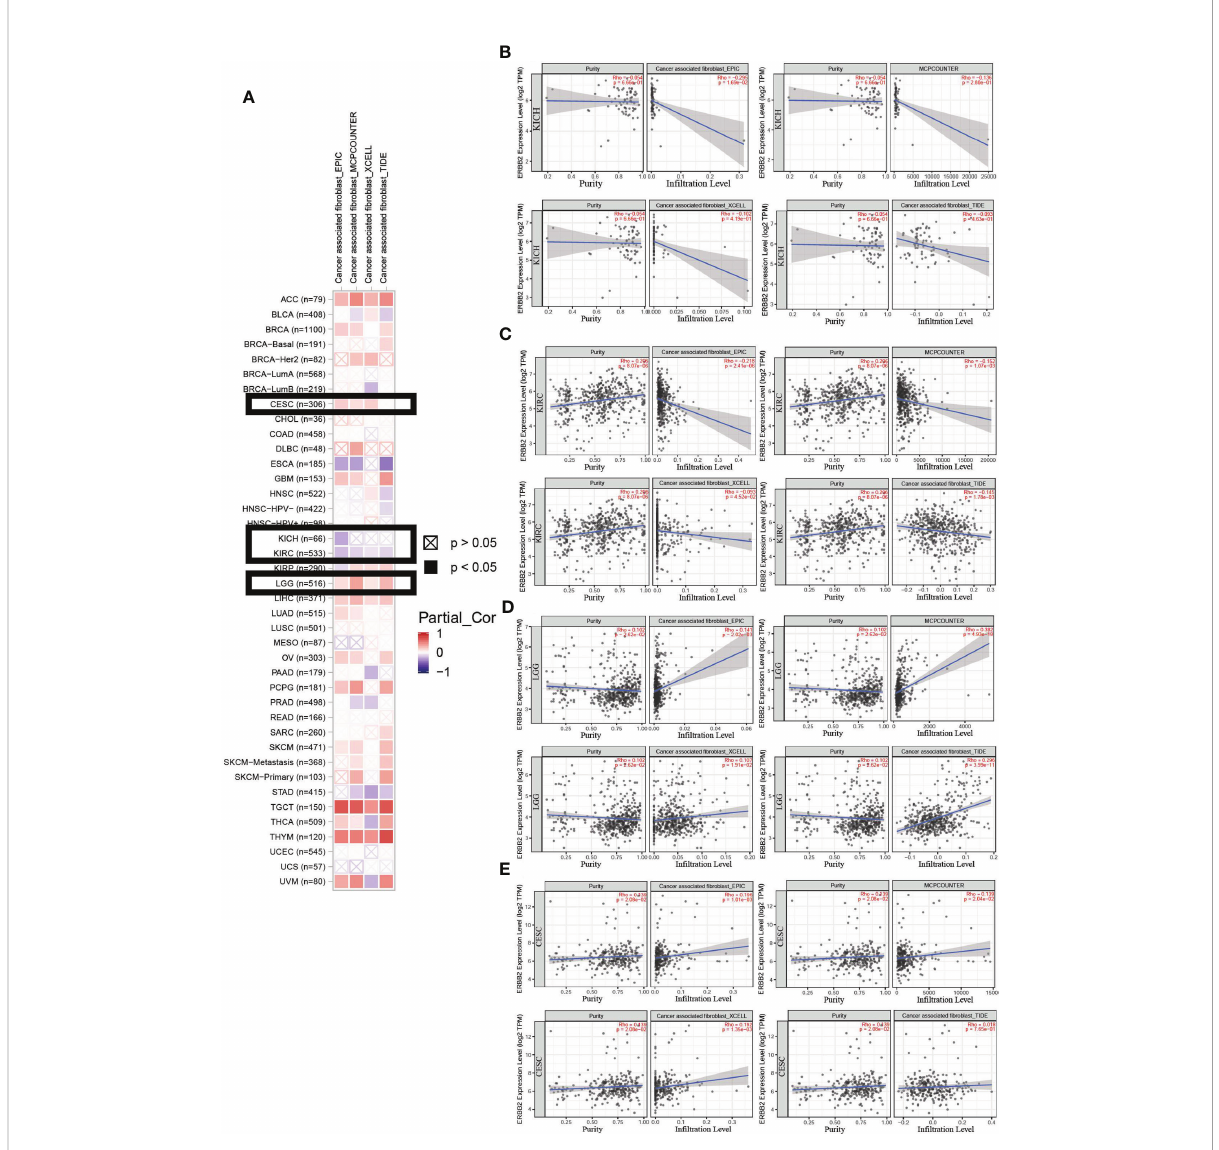
FIGURE 4 An analysis of the cancer-associated fi broblast in fi ltration using the four estimation algorithms. (A) An example of the scatter plot from the ‘ Mutation Module ’ displays the difference in TIMER-estimated cancer-associated fi broblast in fi ltration of KICH, KIRC, LGG, and CESC using the four estimation algorithms, including EPIC, MCP counter, Xcell, and TIDE. Overall, there was a decline in cancer-associated fi broblasts of KIRC (B) and KICH (C) . Moreover, cancer-associated fi broblasts of LGG (D) and CESC (E) present an increasing trend in immune cell in fi